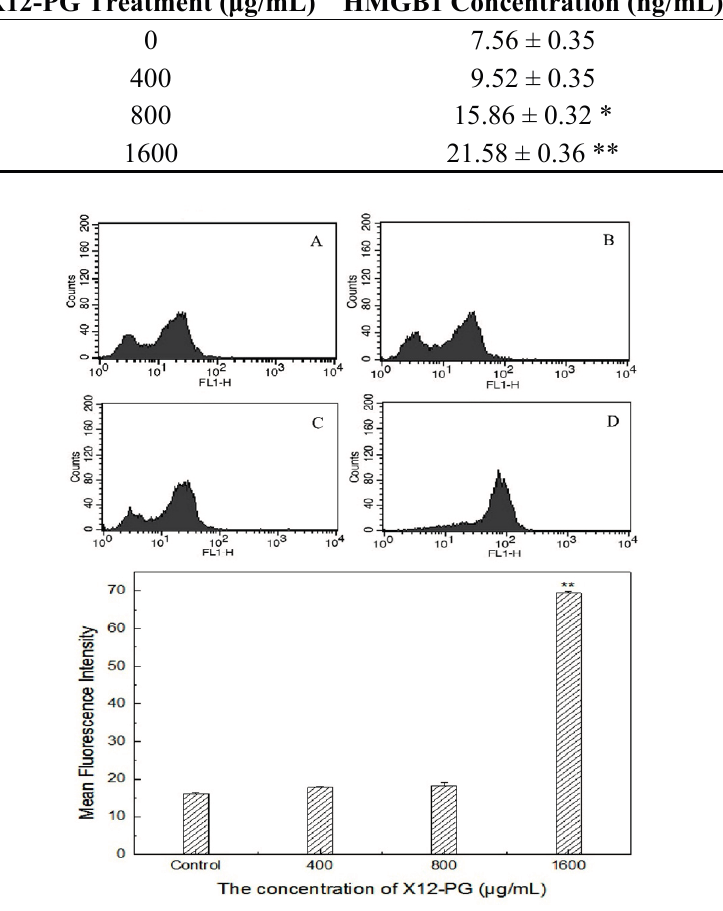
Figure 6. CRT exposure detected by flow cytometry after treatment of X12-PG. Prior to analysis, cells were respectively treated with 0, 400, 800, 1600 μ g/mL ( A – D ) X12-PG for 48 h, then harvested and labeled with FITC. The concentration of CRT on cell membrane was expressed as mean fluorescence intensity (MFI) which has excluded background (Isotype-matched IgG was used as a control: Data not shown). (Error bars are mean ± SD, ** p < 0.01 versus